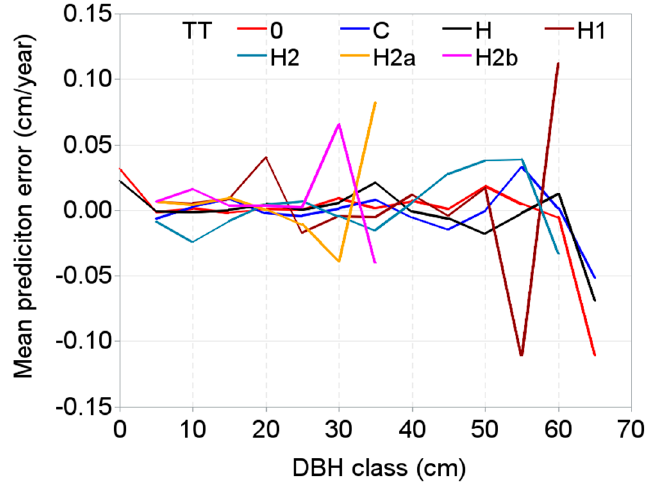
Figure 7. Mean prediction errors of the calibrated mixed-effects diameter increment model (age independent) applied to the individual management regimes. Model was calibrated with the random effects estimated using the measured diameter increment of four randomly selected trees per sample plot; DBH: diameter at breast height; TT = thinning type. Definition of each thinning type is given in Table 1.